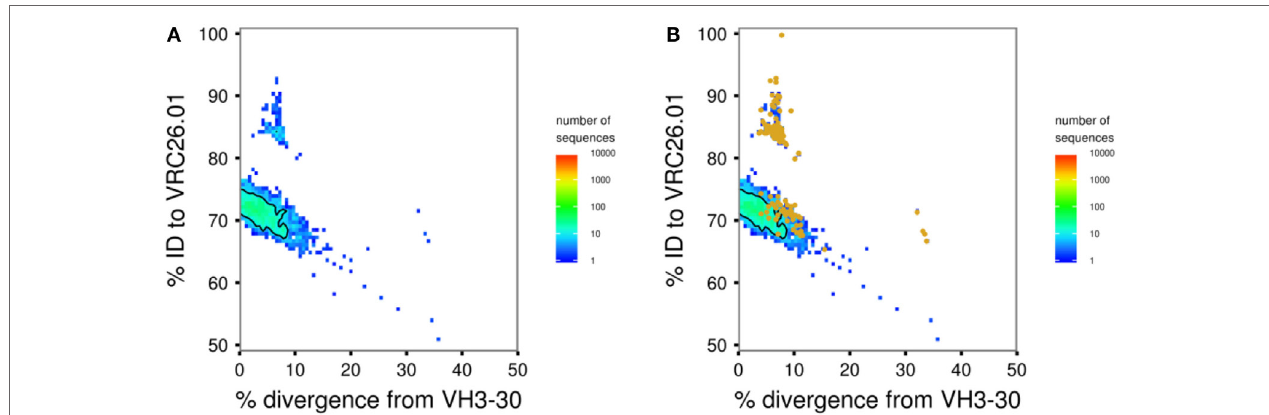
FIgURe 3 | sample figures for Module 2 analyses . (A) Identity–divergence plot of transcripts assigned to VH3-30 for donor CAP256 at 59 weeks post-infection. Bulk sequencing data are shown as a heat map with colors as indicated. The CAP256-VRC26 lineage is visible as a distinct island of transcripts at higher identity. (B) The same plot with transcripts identified as likely lineage members by intradonor analysis overlaid as orange points. Two thirds of these transcripts are found in the high-identity island; the remaining third in the main body of transcripts at ~70% identity are false positives. This is a typical result, showing why multiple tools for lineage determination are included in SONAR and manual curation is strongly